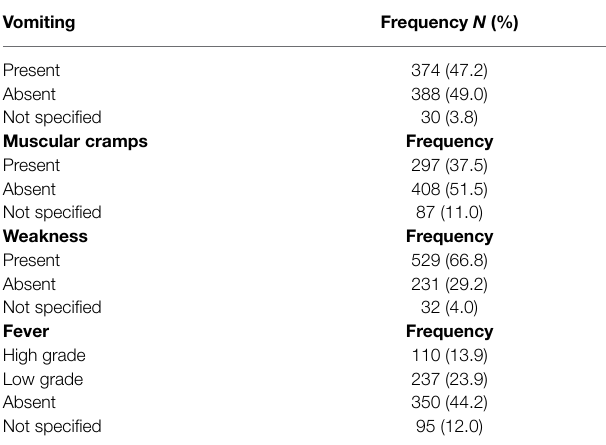
TABLE 1 | Symptoms presented by